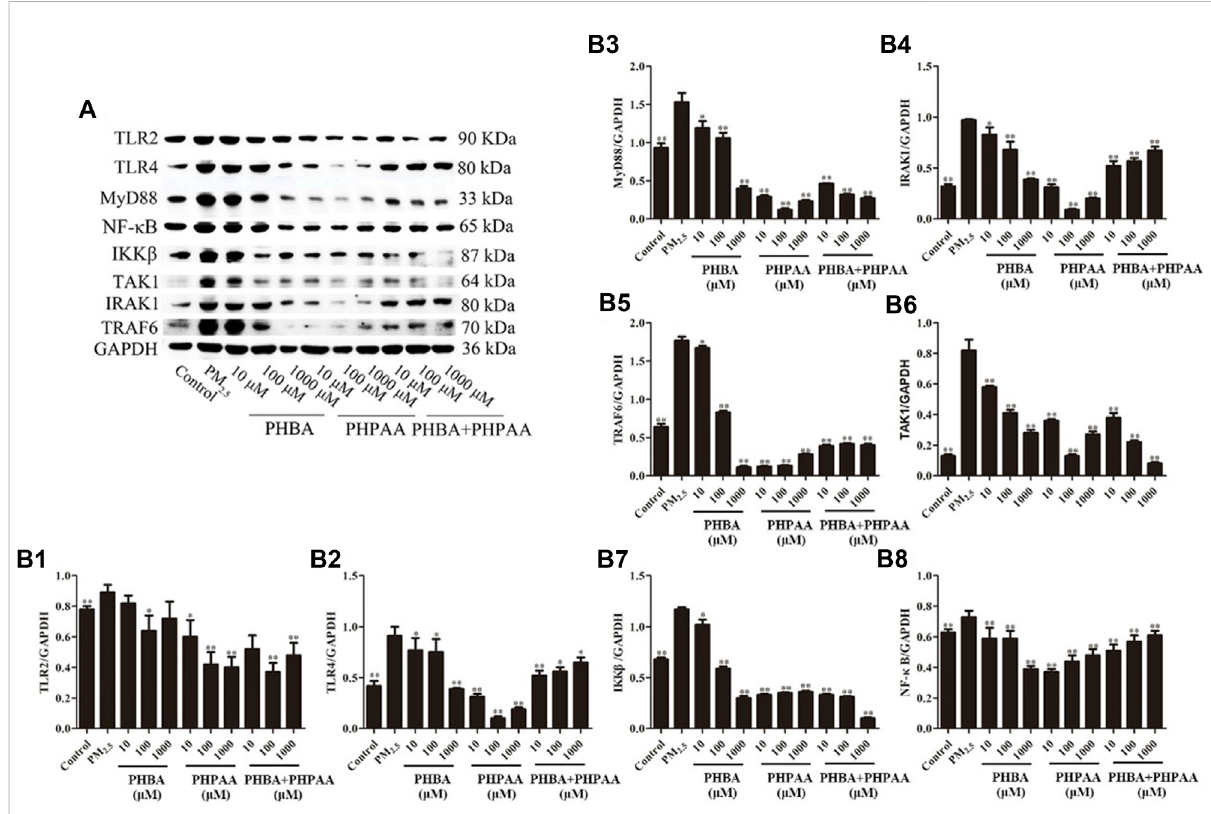
Protein expression of TLRs related pathways. (A) , Representative immunoblots of TLR2, TLR4, MyD88, IRAK1, TRAF6, TAK1, IKK β , and NF- κ B. (B1 – B8) , WB results of TLR2, TLR4, MyD88, IRAK1, TRAF6, TAK1, IKK β , and NF- κ B in cell at 48 h. Values are means ± SD from three